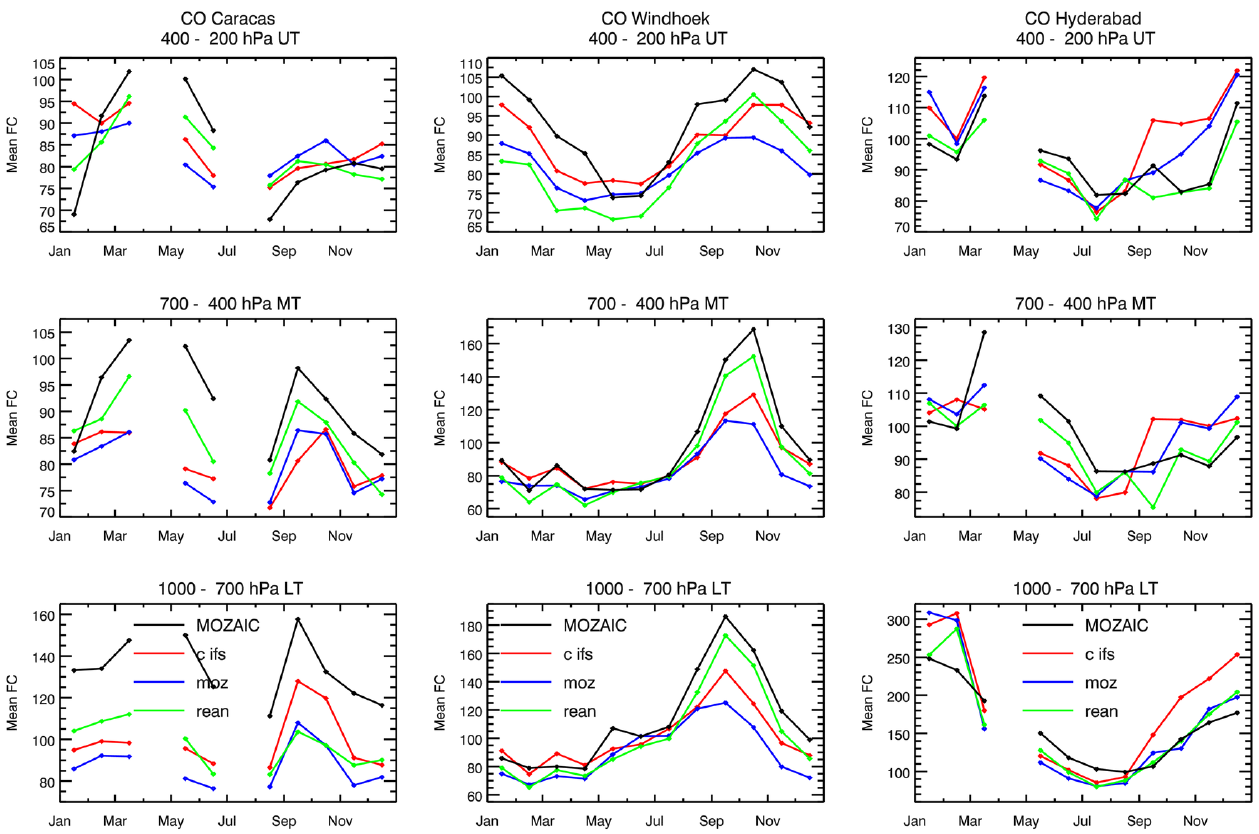
Figure 9. CO volume mixing ratios (ppb) over Caracas (left), Windhoek (middle) and Hyderabad (right), averaged in the pressure bands 1000–700hPa (bottom), 700–400hPa (middle) and 400–200hPa (top) observed by MOZAIC, and simulated by C-IFS (red), MOZ (blue) and REAN (green) in 2008.